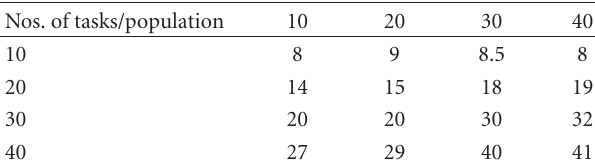
Table 5: Relative execution cost.